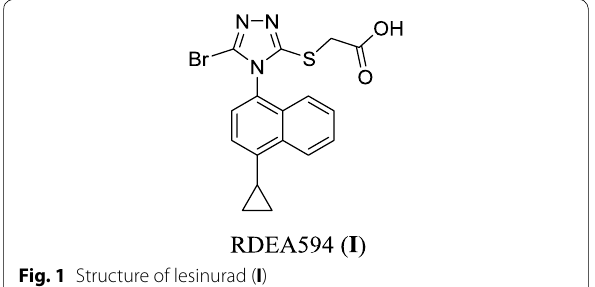
Fig. 1 Structure of lesinurad ( I